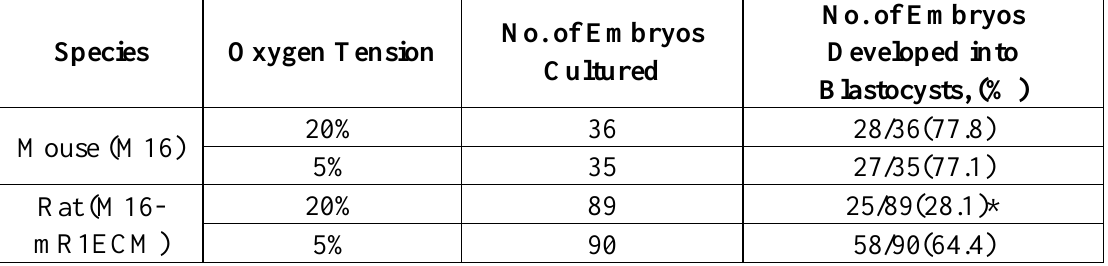
Table 6 . Effects of oxygen concentration on the in vitro developmental ability in rat and mouse zygotes.